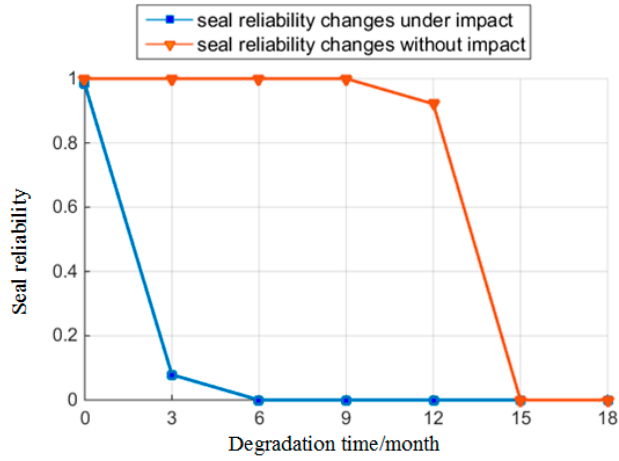
Figure 13. Reliability changes under impact.